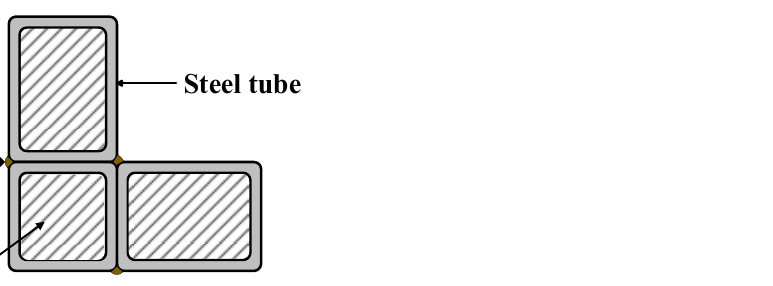
Figure 1. A typical ML-CFST cross-section.